Question: Sum up the contents of this chart in one sentence.
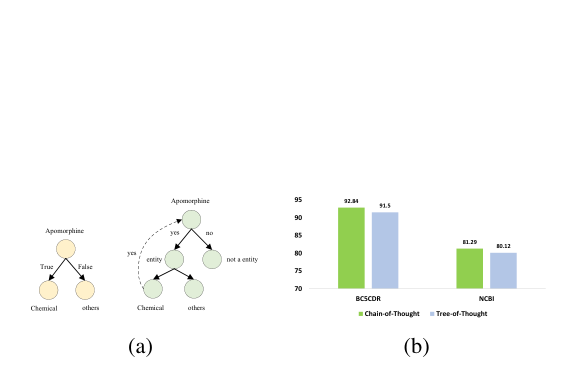
Answer: (a) refers to the comparison of the chain of thought and tree of thought. (b) The LLM performance of the chain of thought and tree of thought.